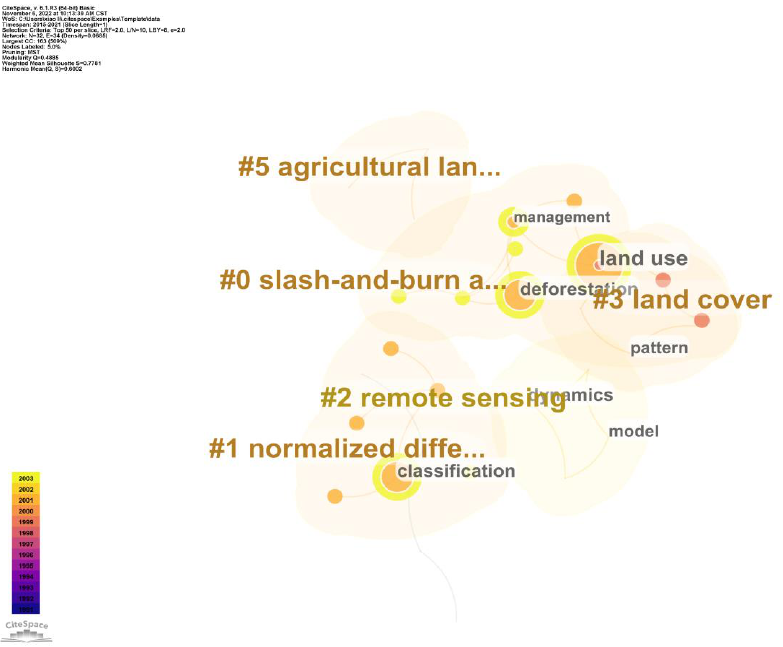
Figure 5. Cluster map of keywords of agricultural land function in the initial stage (the legend represents the color display for each year from 1991 to 2003). Land 2023 , 12 , 561